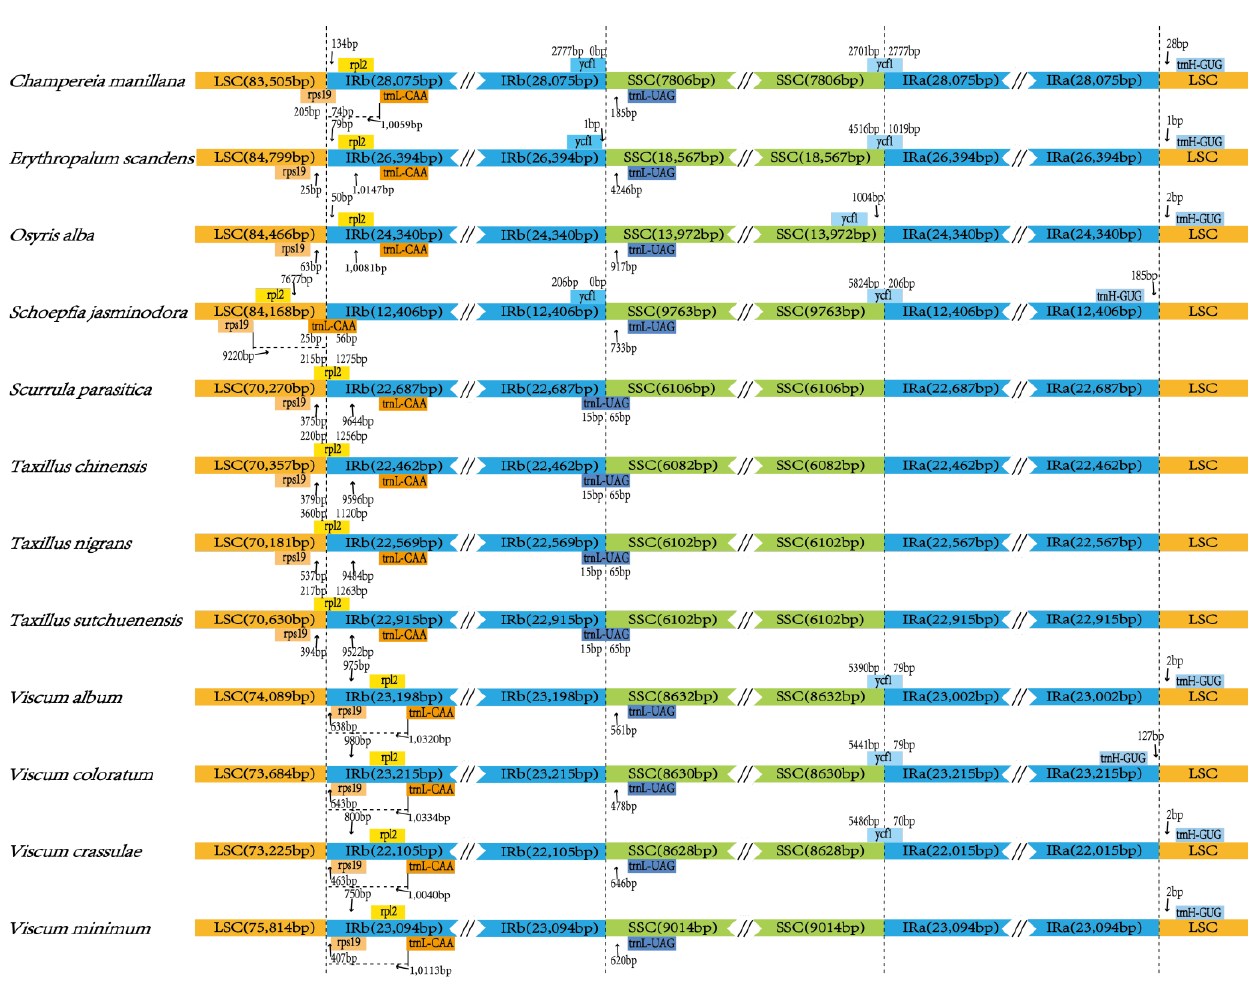
Figure 4. Comparison of border distance between adjacent genes and junctions of the LSC, SSC, and two IR regions among the chloroplast genomes of the 12 species of Santalales (The figure shows relative changes at or near the IR/SSC borders).